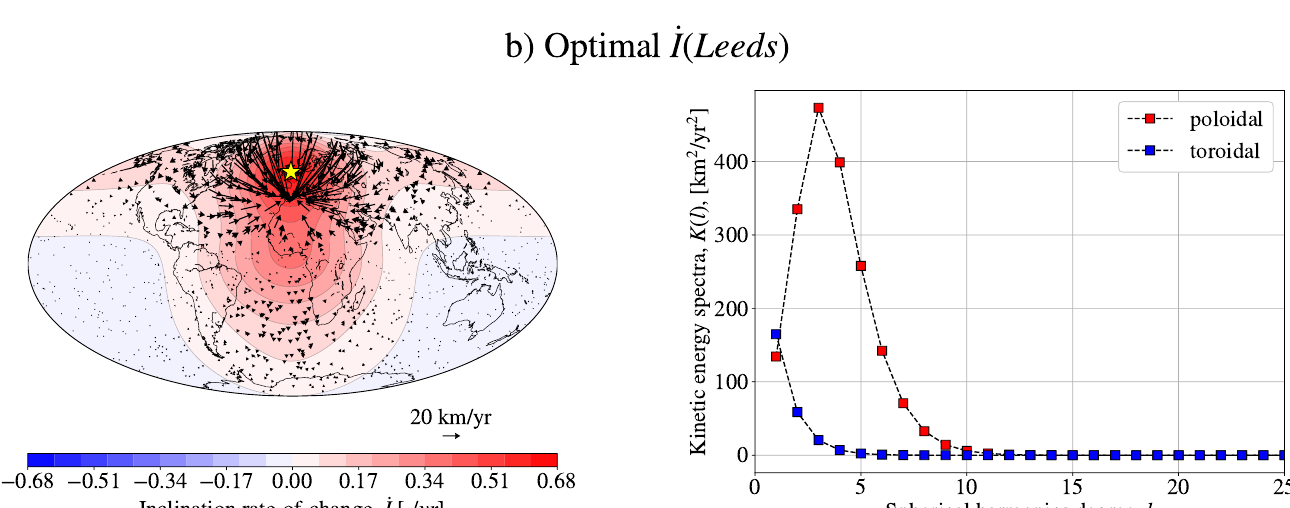
= − 29,410.65 nT. A 1 d . The global plots on the left show the